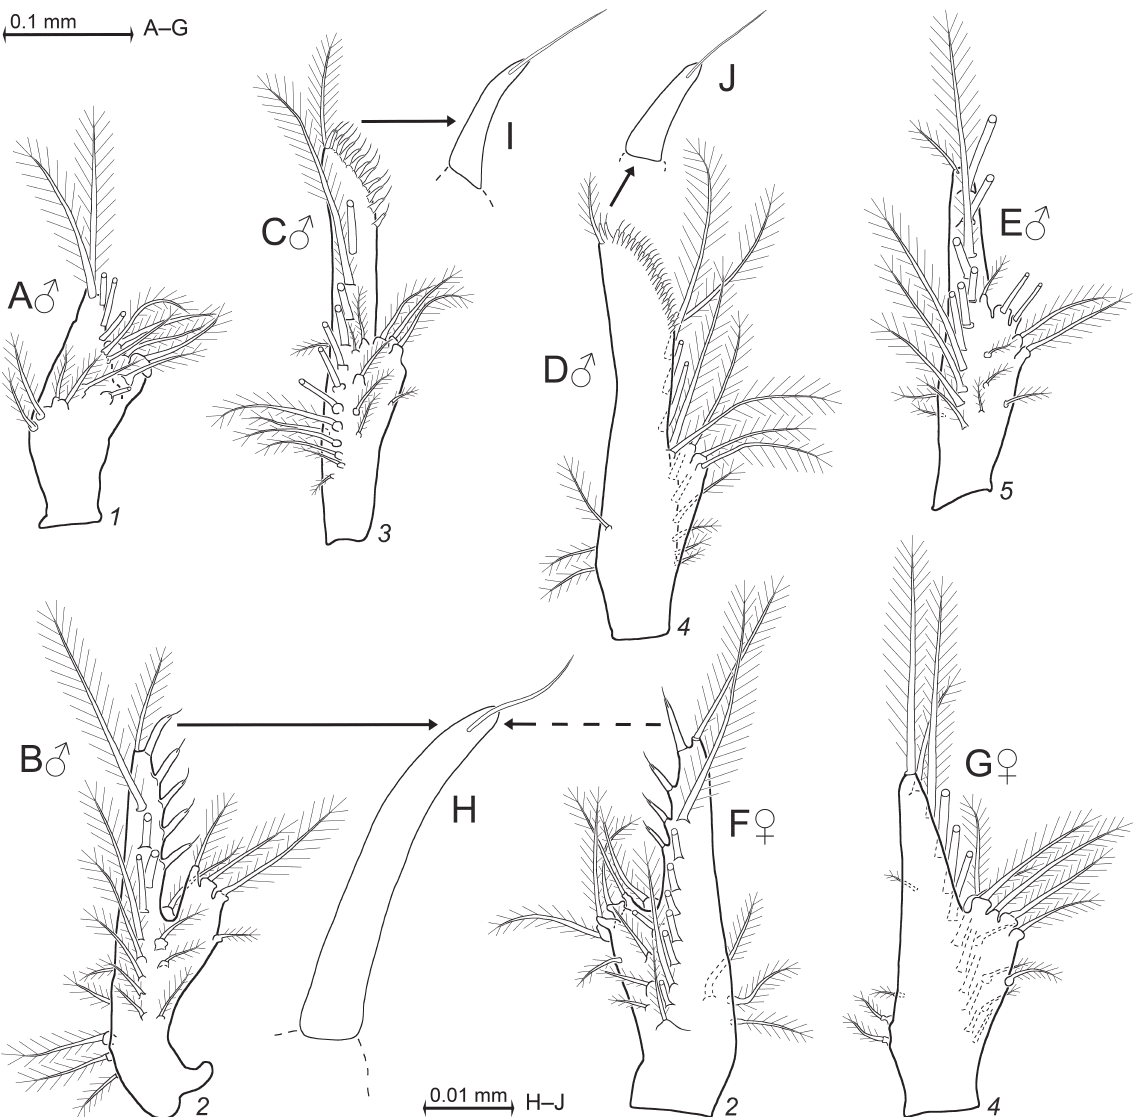
Fig. 7. Heteromysis hornimani sp. nov., paratypes from London, ♂ with body length 4.7 mm (A–E, H–J: NHMW 26976 ), ♀ 5.2 mm (G: NHMW 26975 ), and non-type from Brest, ♀ 4.3 mm (F: